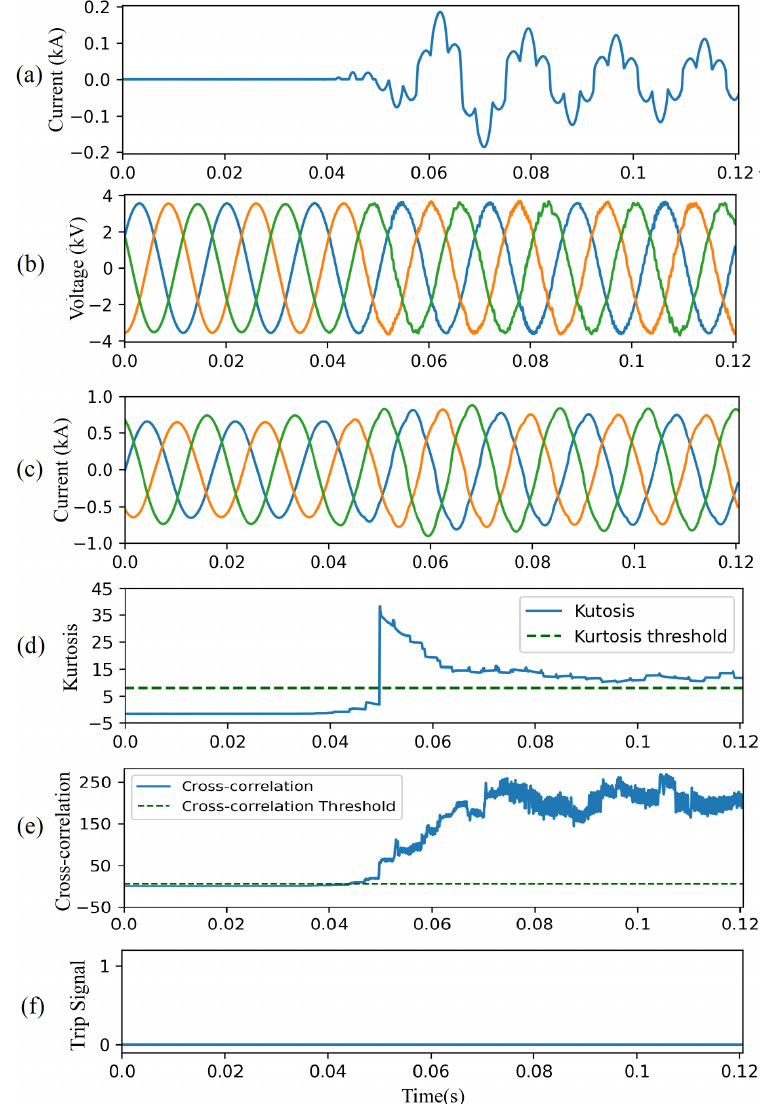
Figure 14. CAE-HIFD performance under non-linear load switching: ( a ) non-linear load current, ( b ) three-phase input voltages, ( c ) three-phase input currents, ( d ) kurtosis, ( e ) cross-correlation, and ( f ) trip